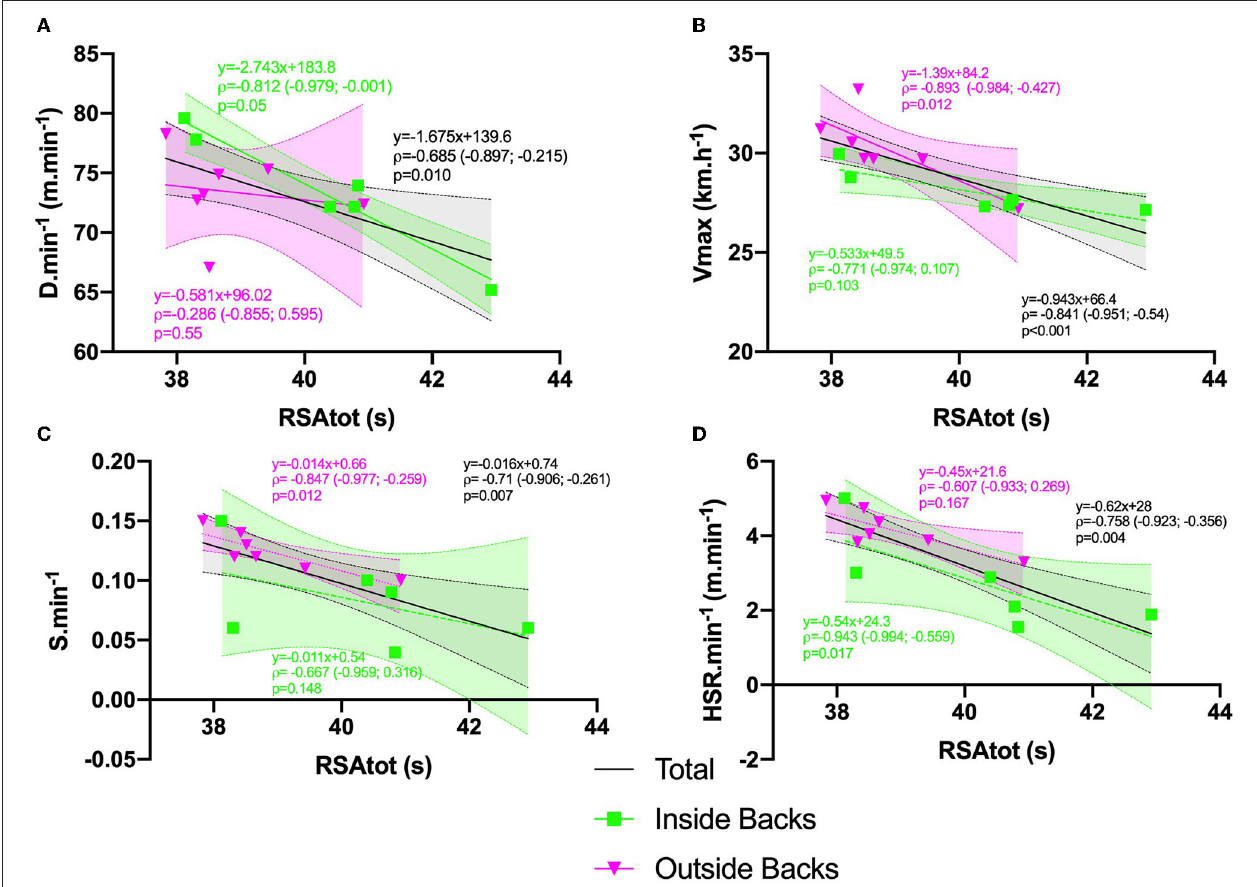
FIGURE 2 | Relationships between physical abilities and player movement characteristics in game in backs: (A) Relationships between RSAtot and distance per minute (D · min − 1 ) in backs; (B) Relationships between RSAtot and maximal velocity (Vmax; km · h − 1 ) in backs; (C) Relationships between RSAtot and sprint frequency (S · min − 1 ) in backs; (D) Relationships between RSAtot and high-velocity running distance (HSR · min − 1 ; m.min − 1 ) in